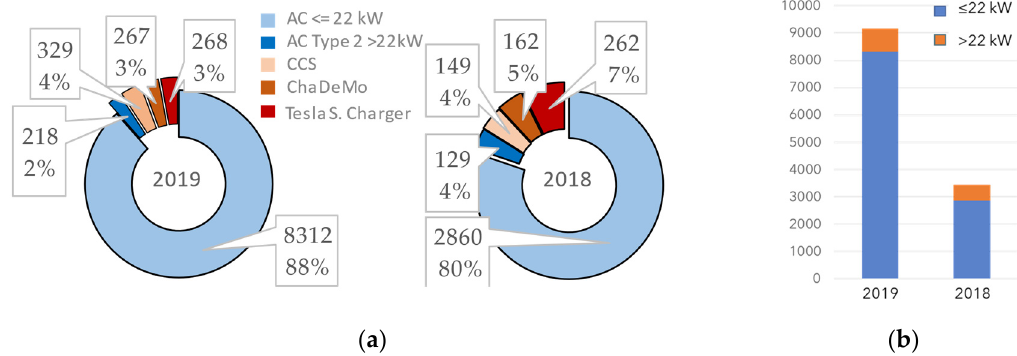
Figure 2. Charging station (CS) data, Italian population: ( a ) number and percentage of “normal” and “fast” CSs in 2018 and 2019; ( b ) the total number of CSs in 2018 and 2019.